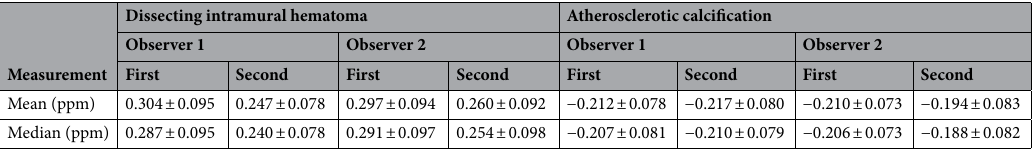
Table 1. QSM values of dissecting intramural hematomas and atherosclerotic calcifications. * Data indidcate mean ± standard deviation.